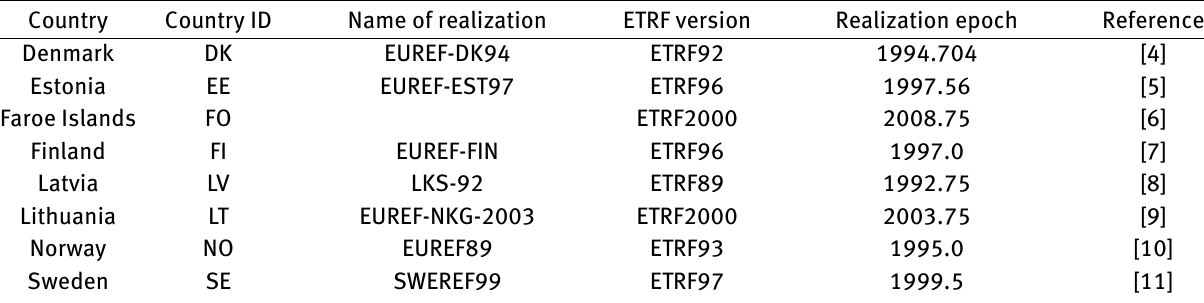
Table 1: Nordic and Baltic ETRS89 realizations.